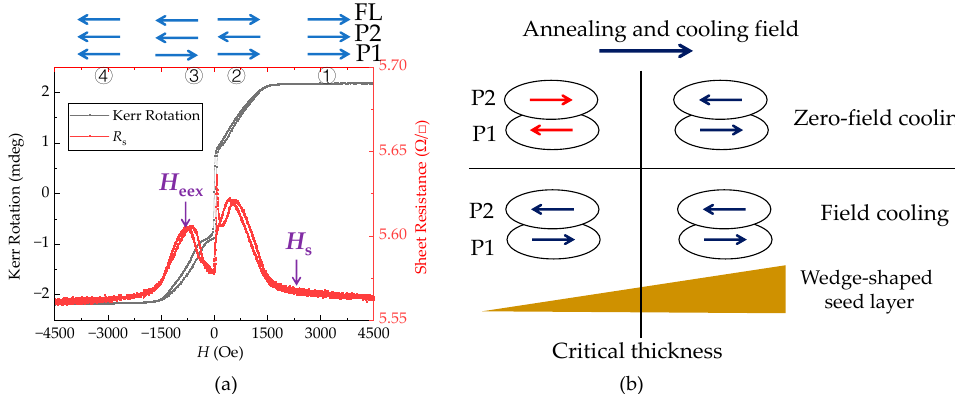
Figure 6. ( a ) Magnetization loops (black line) and Rs-H loops (red line) of the film with t NiFeCr = 8.2 nm; ( b ) magnetization evolutions of P1 and P2 under different annealing processes.